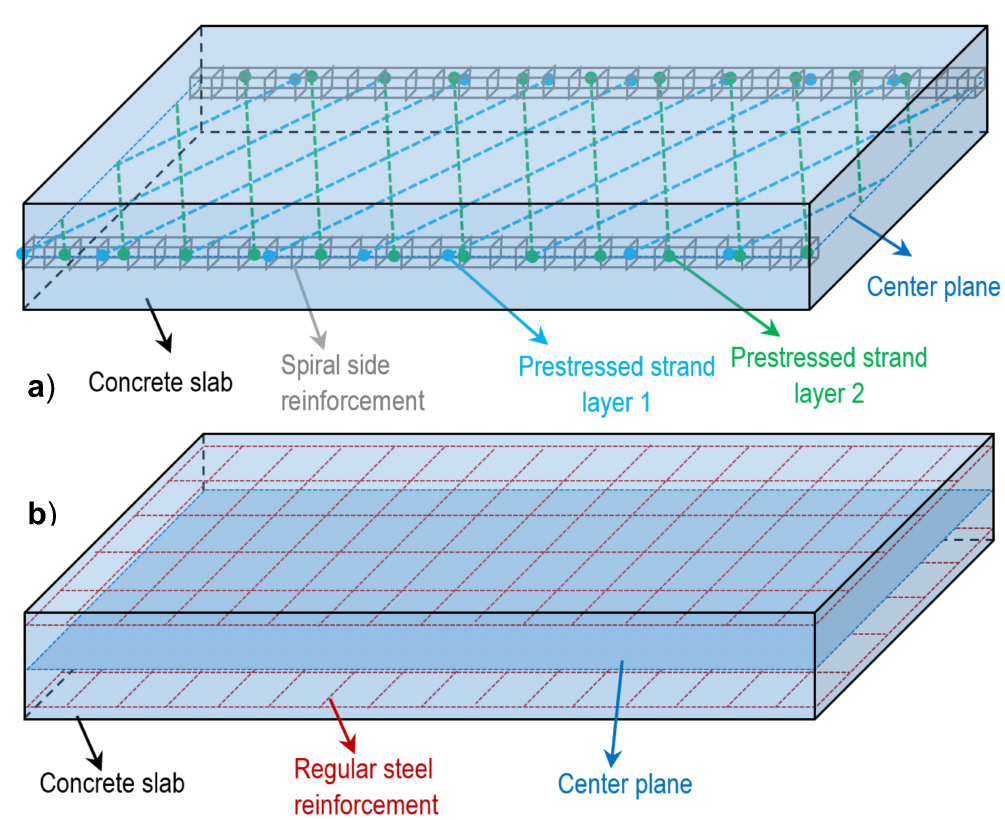
Figure 7. Illustration of the design of demonstrative oblique prestressed concrete pavement: ( a ) the distribution of oblique prestressed strands and side reinforcement; ( b ) the distribution of regular steel